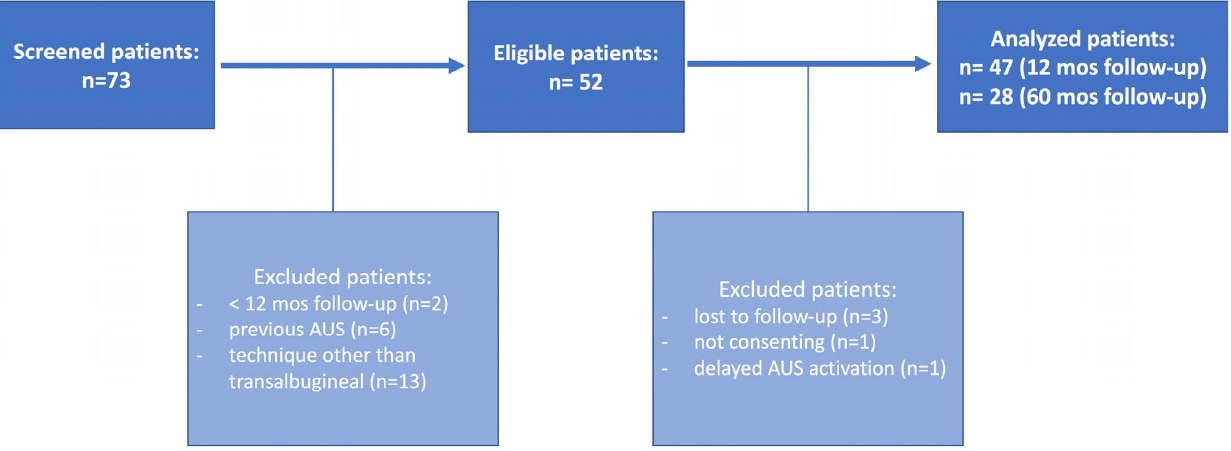
Figure 6. Study flowchart. Table 1. Patient baseline characteristics (n = 47): (data are reported as the median and IQR or number and percentage).